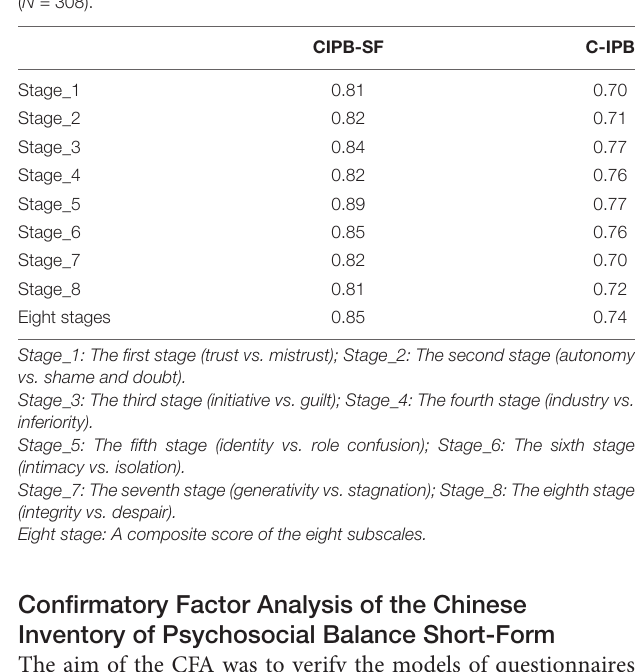
TABLE 3 | Reliability coefficients (Cronbach’s α ) for the CIPB-SF and C-IPB ( N =